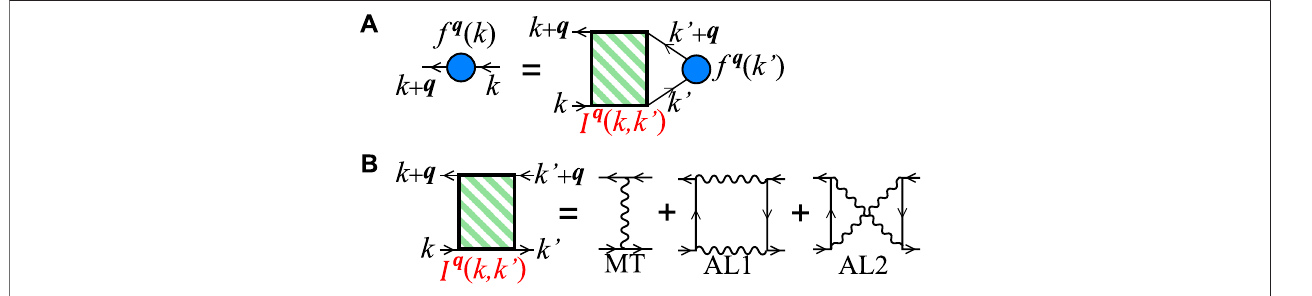
FIGURE 3 | Feynman diagrams of (A) DW equation and (B) charge-channel irreducible four-point vertex. Each wavy line represents a spin- fl uctuation-mediated